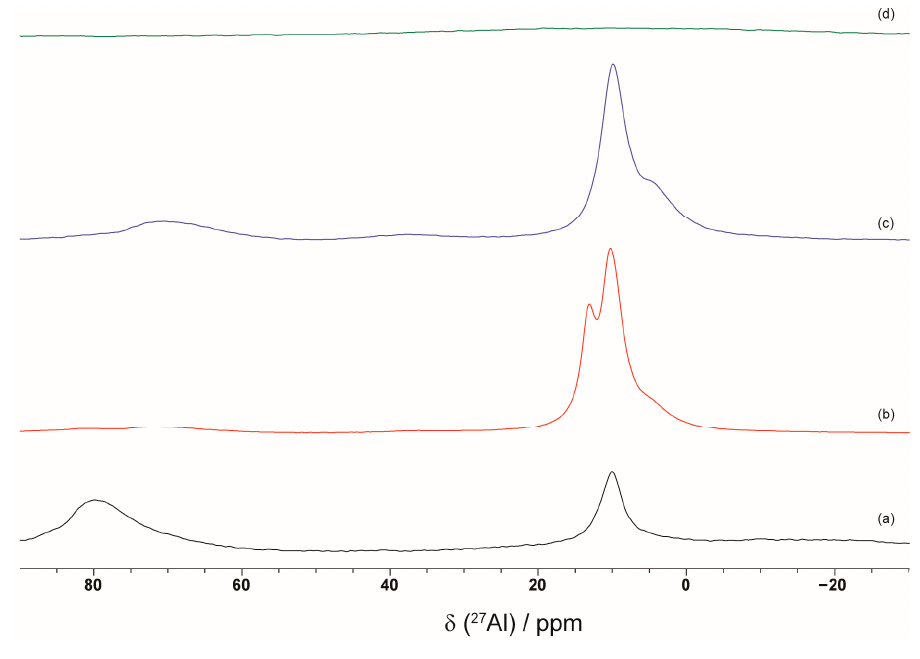
Figure 10. 27 Al MAS NMR spectra of ( a ) CEM, ( b ) CP, ( c ) CP10VSW and ( d ) VSW samples.